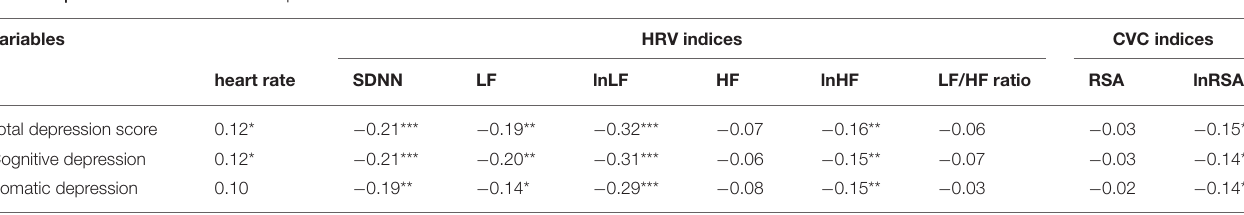
TABLE 4 | The correlations between depression and baseline HRV and CVC